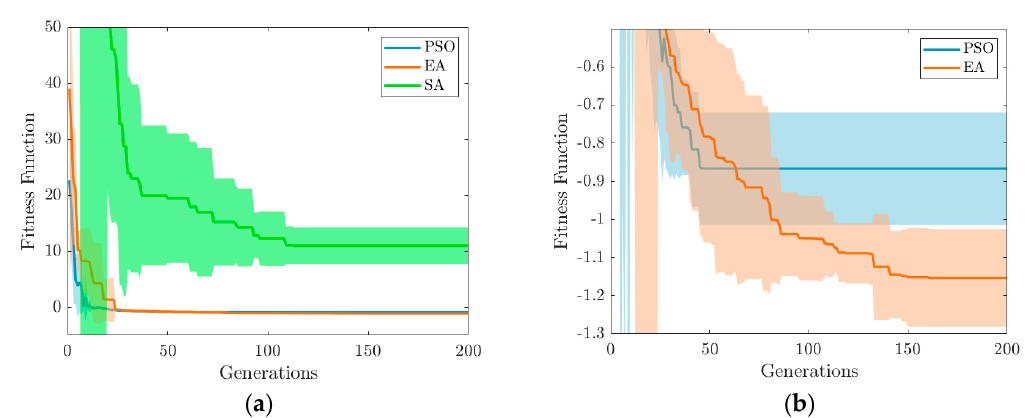
Figure 15. ( a ) Comparison of performance of evolutionary algorithm (EA) against particle swarm optimization (PSO) and simulated annealing (SA) in terms of average fitness and standard deviation over 20 runs. ( b ) Close up view of the comparison between EA against PSO.